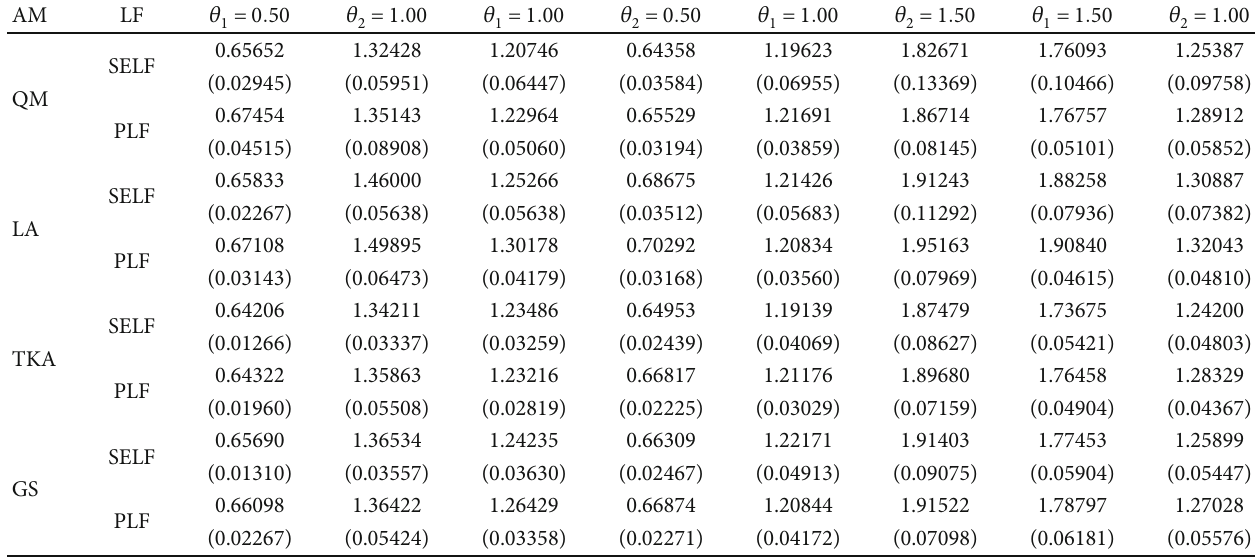
Table 5: BEs and PRs (in parentheses) under IP for n = 15